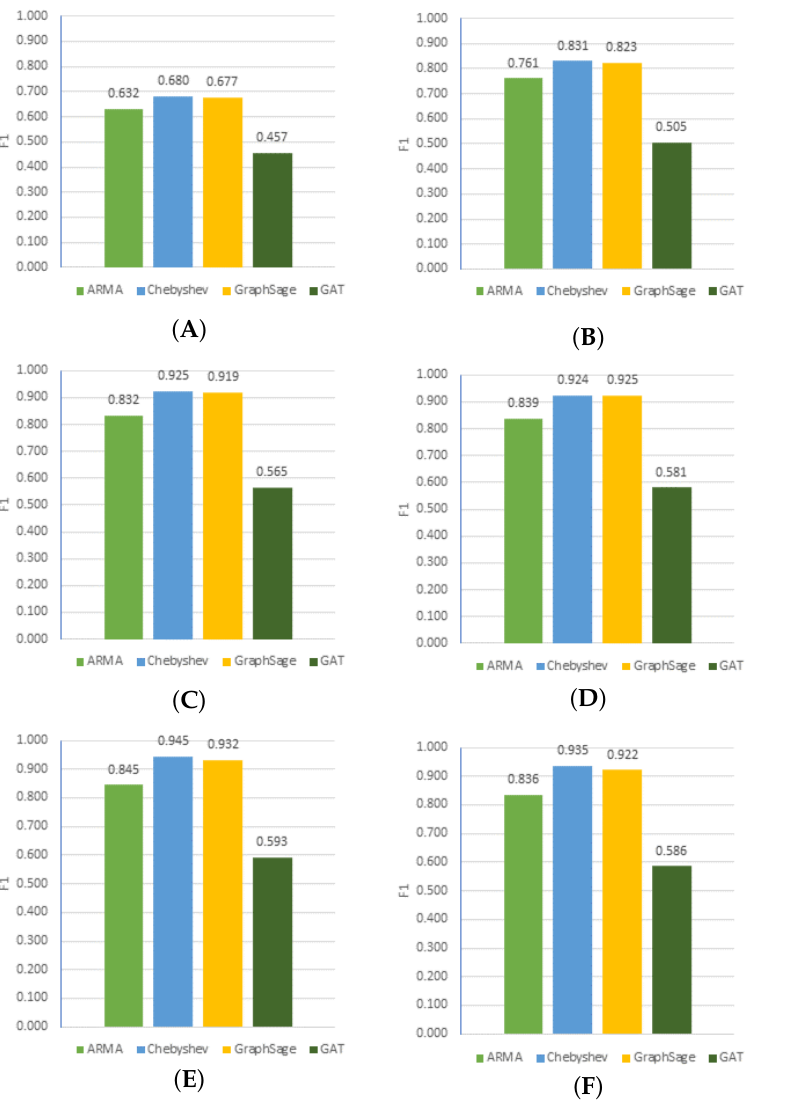
Figure 10. Comparison of the quality of three graph neural network models, ARMA, Chebyshev, and GraphSAGE, for different document lengths measured by word count. ( A ) 35, ( B ) 50, ( C ) 100, ( D ) 150, ( E ) 200, and ( F )